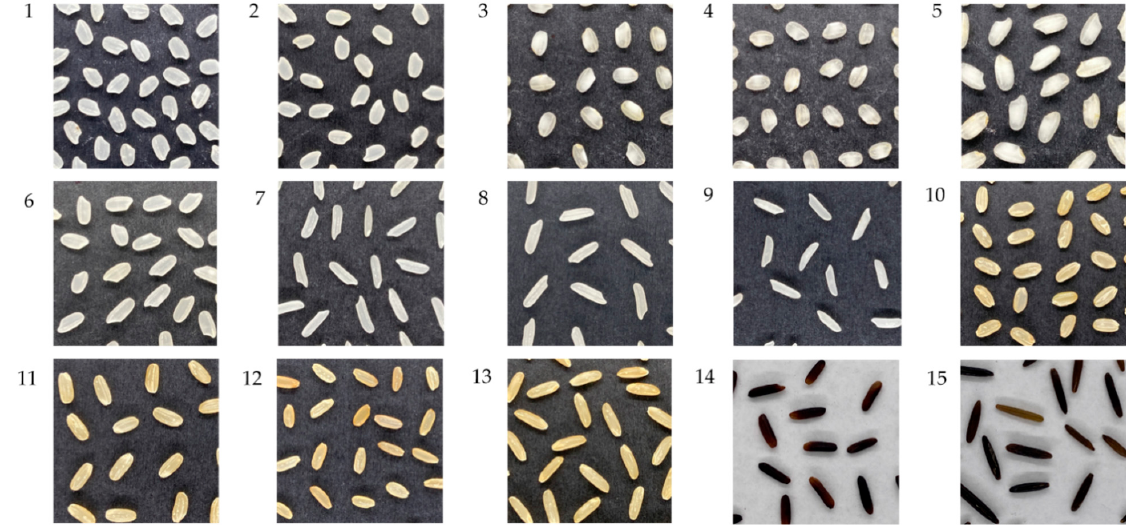
Figure 2. Examples of the 15 commercial rice sample images used in the study. The details of the rice samples based on the labeled class ID correspond to the list in Table 1. Rice sample images shown in the figure were cropped for presentation purposes only.